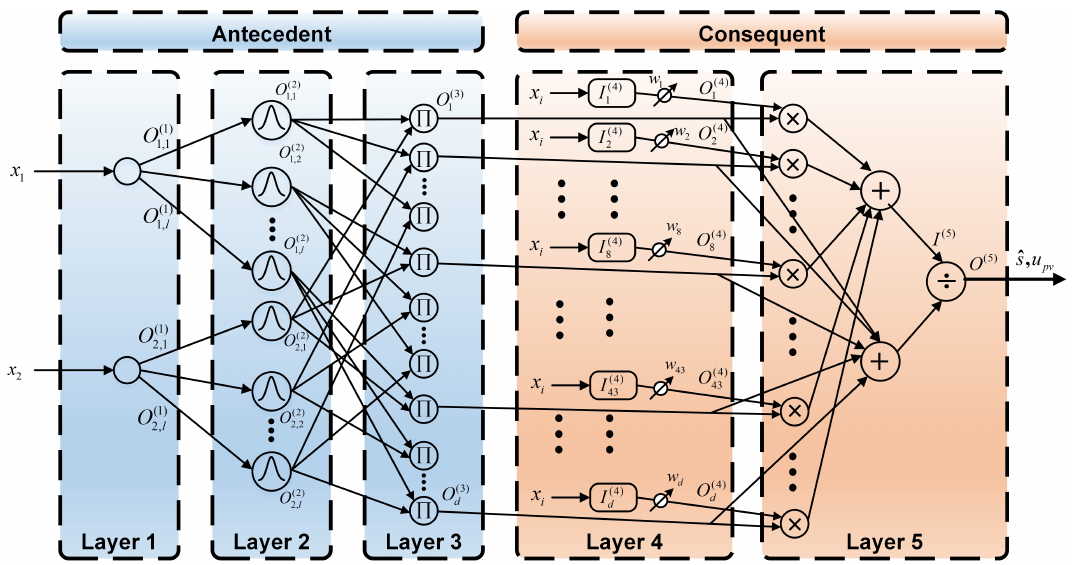
Figure 3. Structure of the proposed HWANFC and HWNF-based gradient